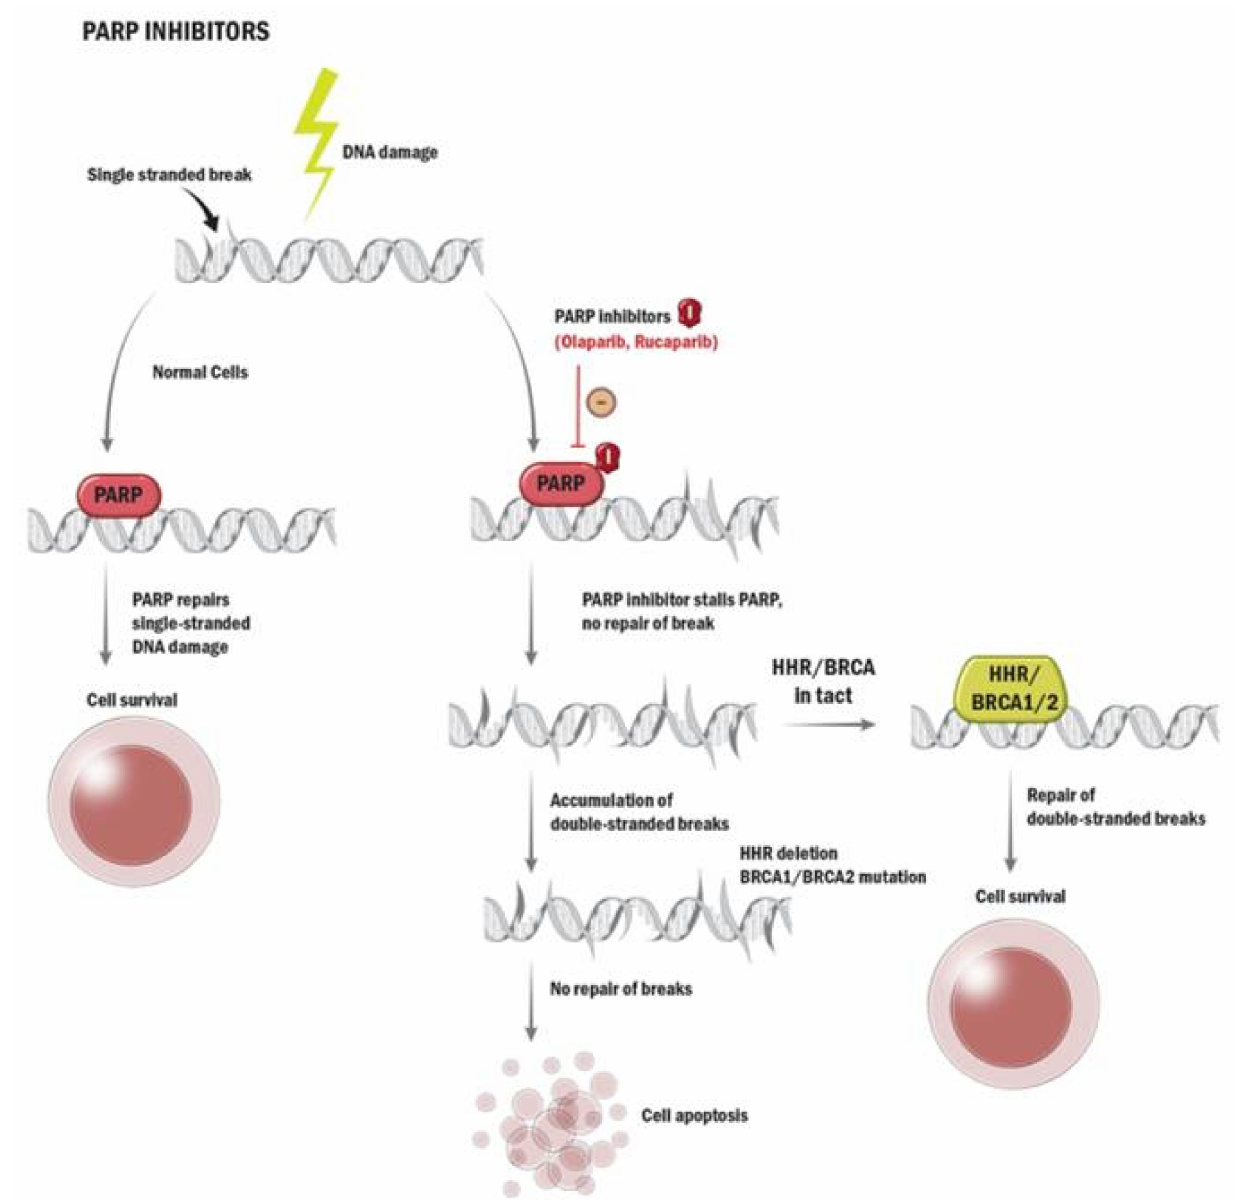
Figure 3. Mechanism of action of PARP inhibitors. Poly (ADP-ribose) polymerase (PARP) is a protein involved in repair of single-stranded DNA breaks. When inhibited by a PARP inhibitor drug (represented by a red oval with the letter “I”), the PARP protein stalls at its attachment point on DNA strands. This lack of repair of single-stranded breaks leads to accumulation of double-stranded breaks. In patients who also lack double-stranded repair mechanisms, such as those with homologous recombination repair (HRR) gene mutations, this leads to synthetic lethality and cell